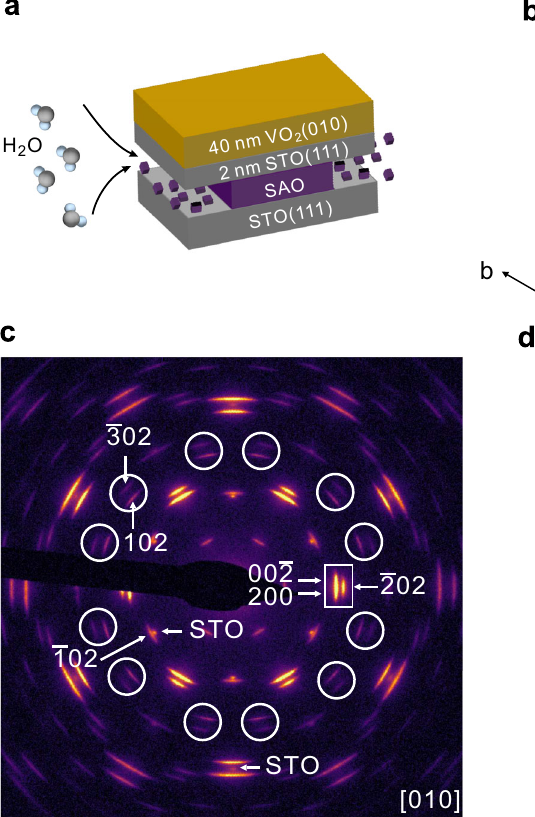
(cid:1) (cid:1) (cid:1) (cid:1) 10 2 = 10 2 T .Each120 o